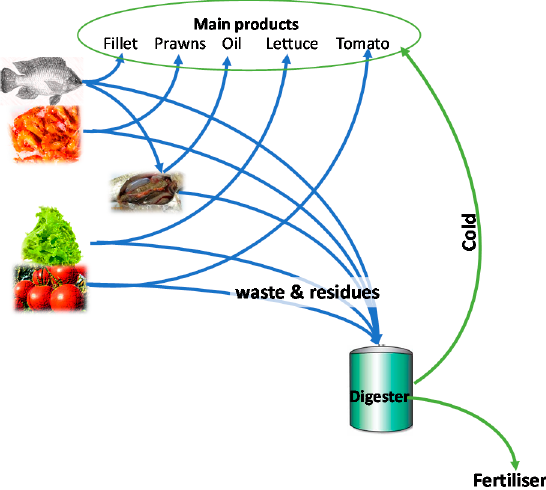
Figure 2. The graphical presentation of case study with a biogas valorisation approach integrated into the main activity of company.